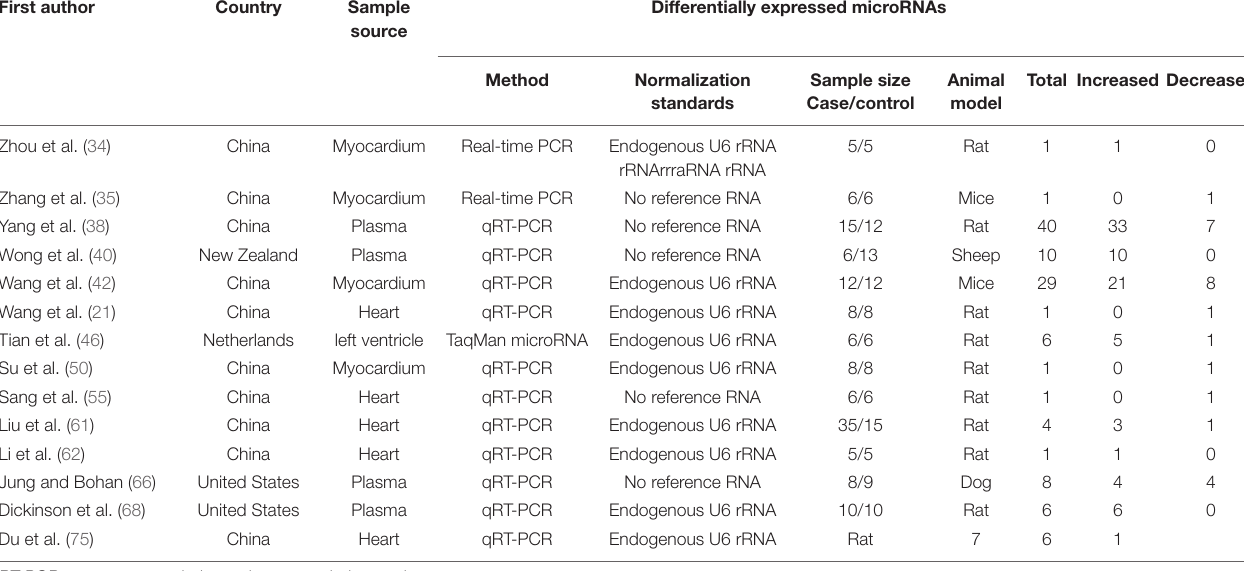
TABLE 2 | The characteristics of the included animal miRNA expression studies.